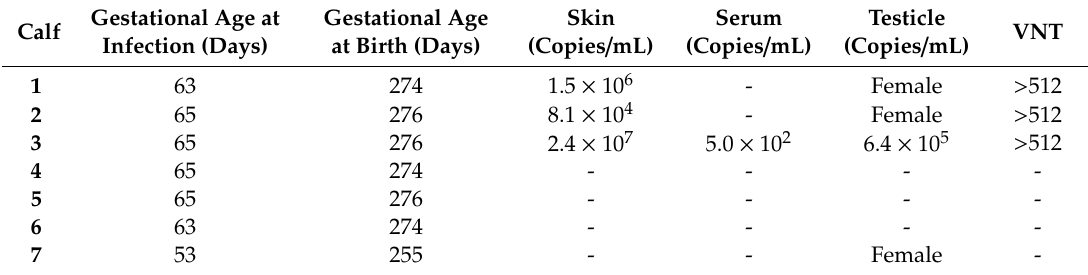
Table 7. Summary of laboratory results for progeny of cows infected with Bungowannah